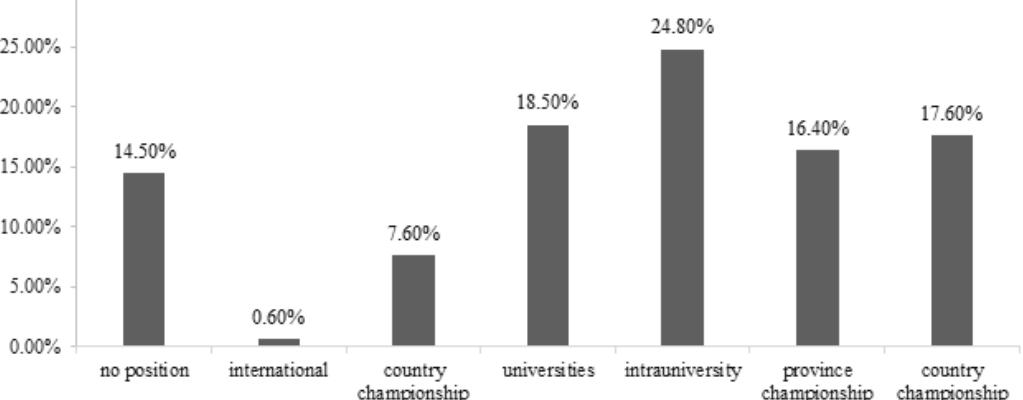
Figure 1. The status of the championship of university students.